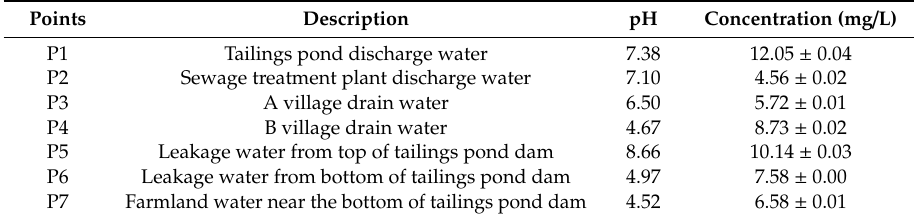
Table 1. U concentrations in percolating water samples ( n =